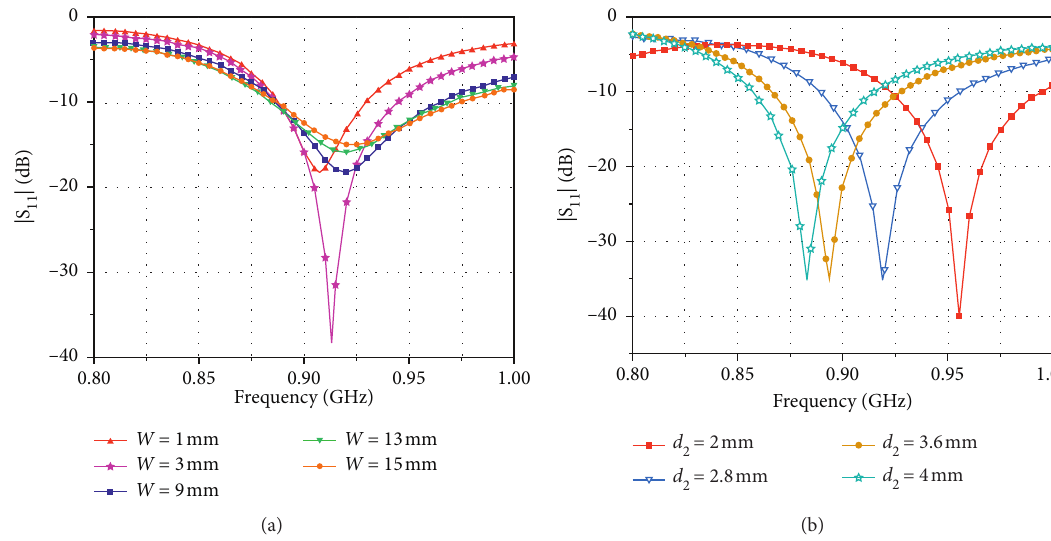
Figure 2: Simulated |S 11 | of the proposed antenna with variations of values: (a)